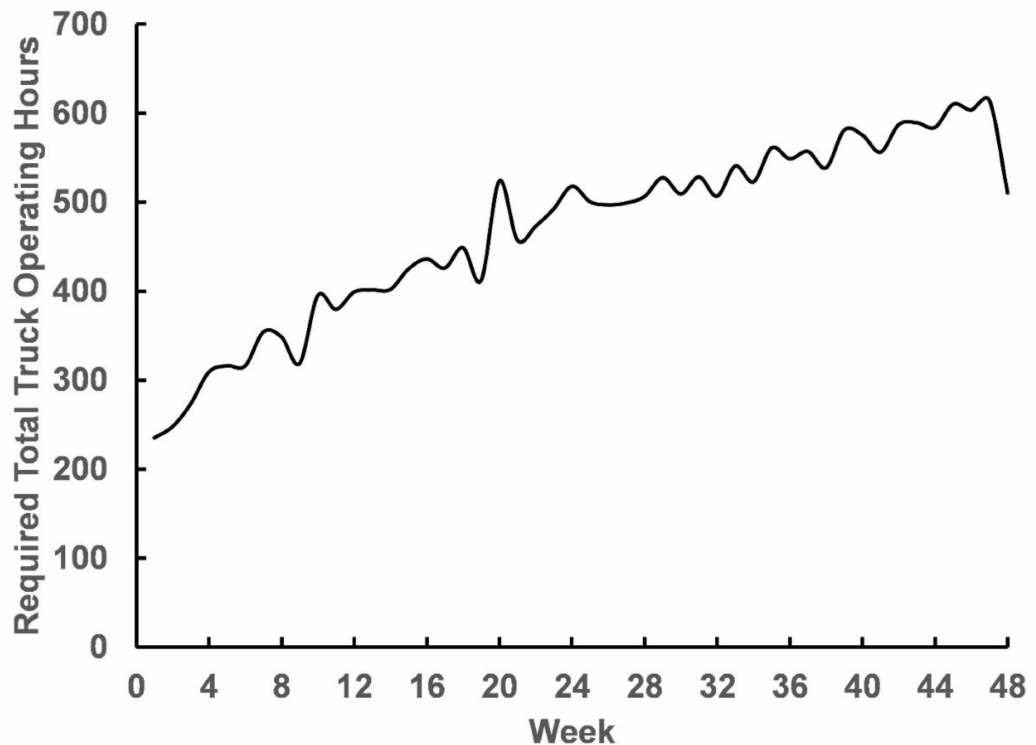
Figure 7. Required weekly truck fleet operating hours over the 49-week season of the eight-load-out